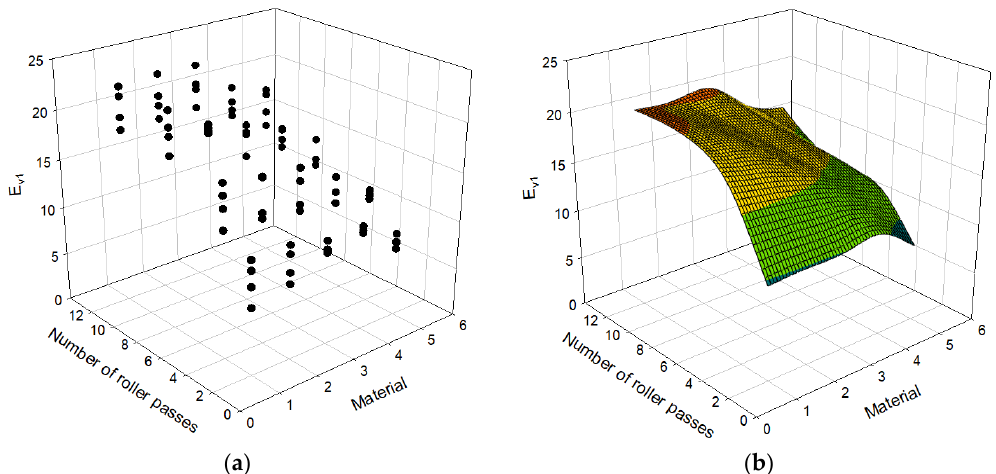
Figure 8. Relationship between number of roller passes and E v1 : ( a ) scatter plot; ( b ) surface plot.